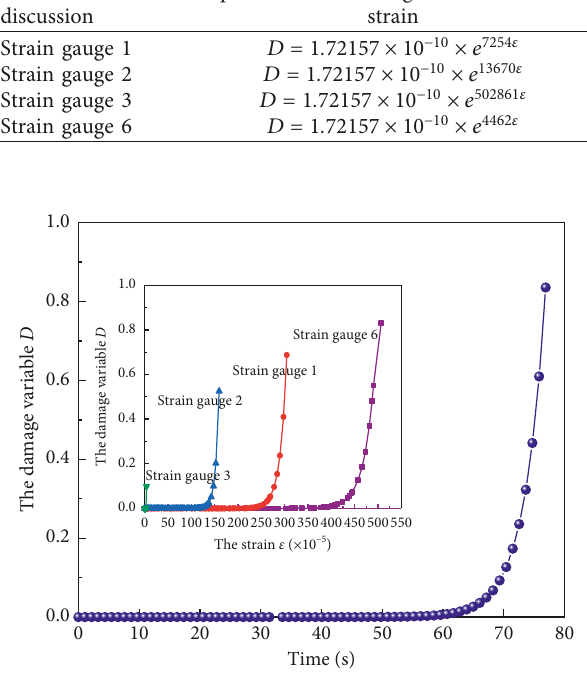
Figure 8: The evolution curves of the damage variable.